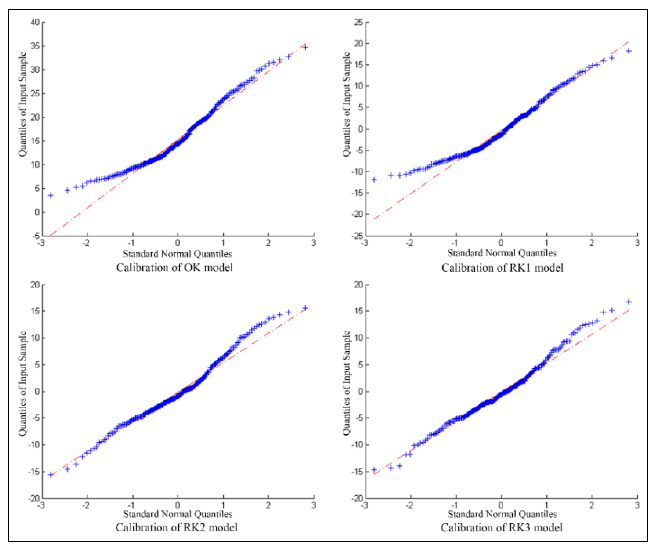
Figure 2.QQplots of four calibration